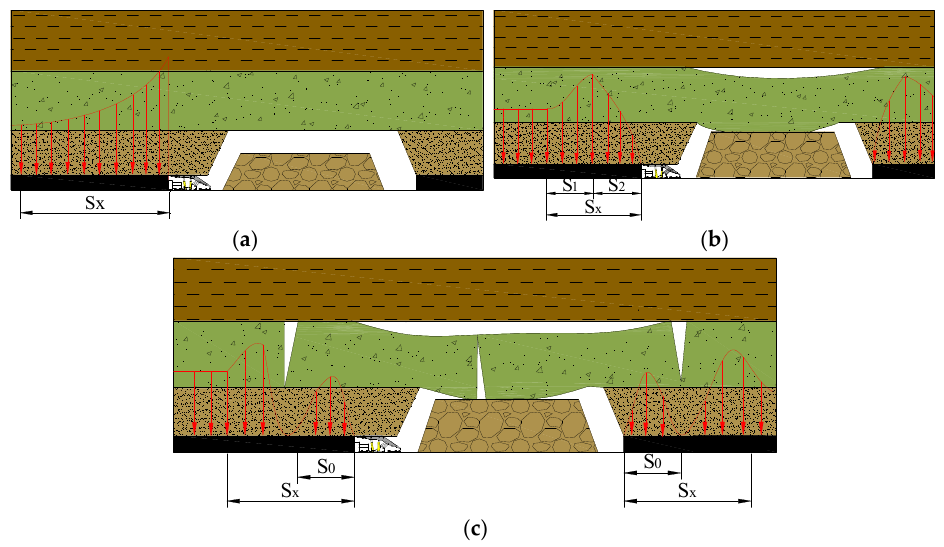
Figure 1. Development stage of abutment pressure. ( a ) Maintains elastic supporting capacity; ( b ) Loses elastic supporting capacity; ( c ) Formation of internal and external stress